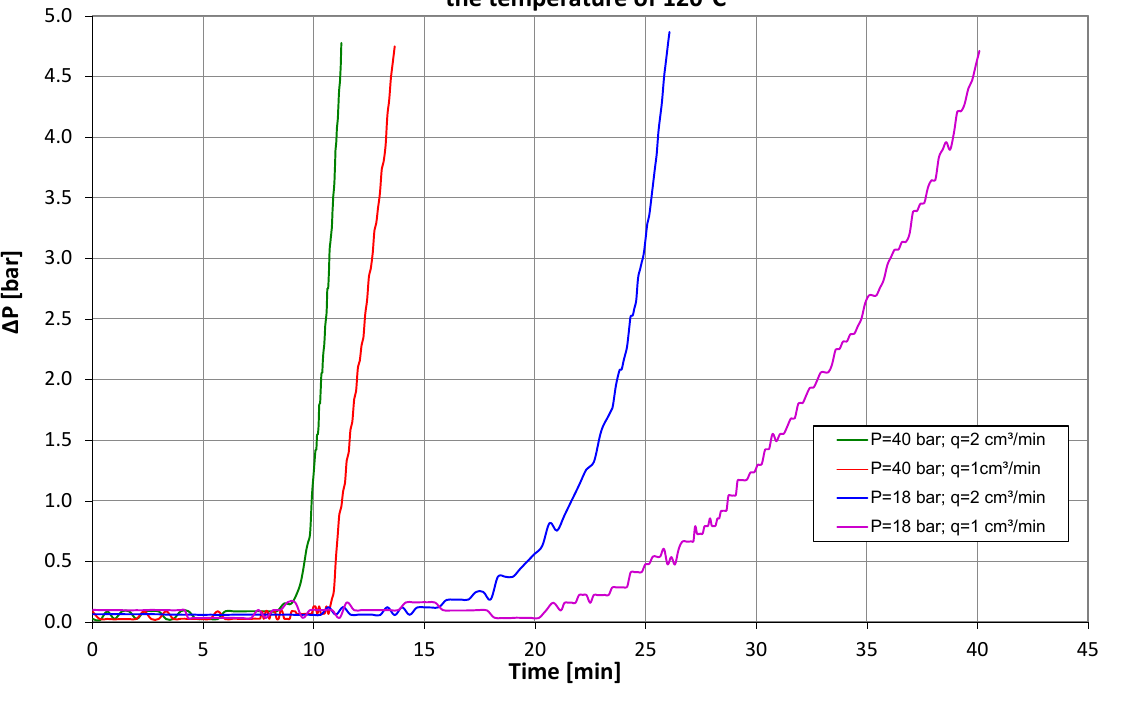
Figure 5. Tests for the precipitation of sediments for water “A” modified with sodium bicarbonate (2 g/800 mL) and water “B” at a temperature of 120 °C (measurement error is ±4%).